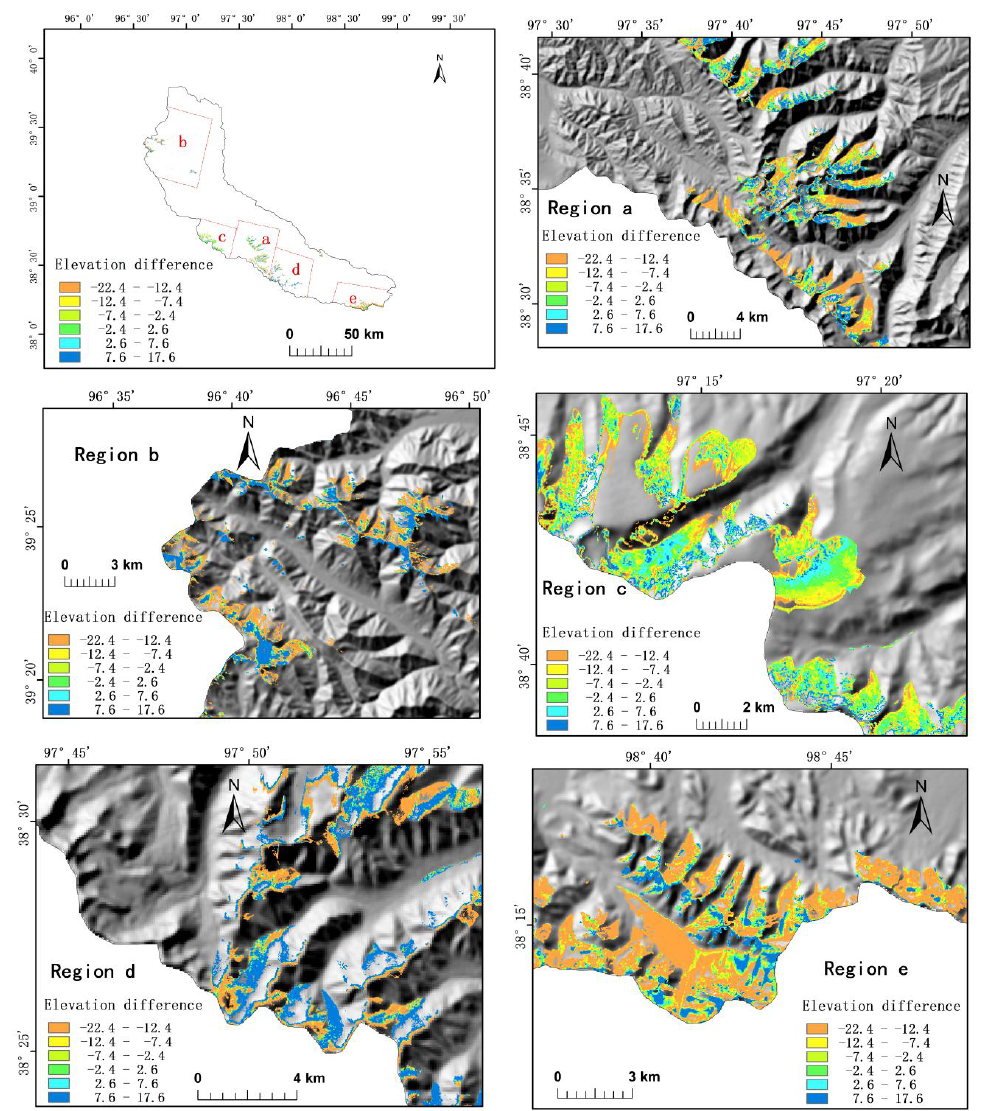
Figure 7. Glacier ice surface elevation changes from 2000 to 2015 in sub-region a, b , c , d , and e in the Upper Reach of Shule River Basin. Table 3. Changes in glacier area and ice surface elevation of each subregion of the Upper Reach of Shule River Basin.